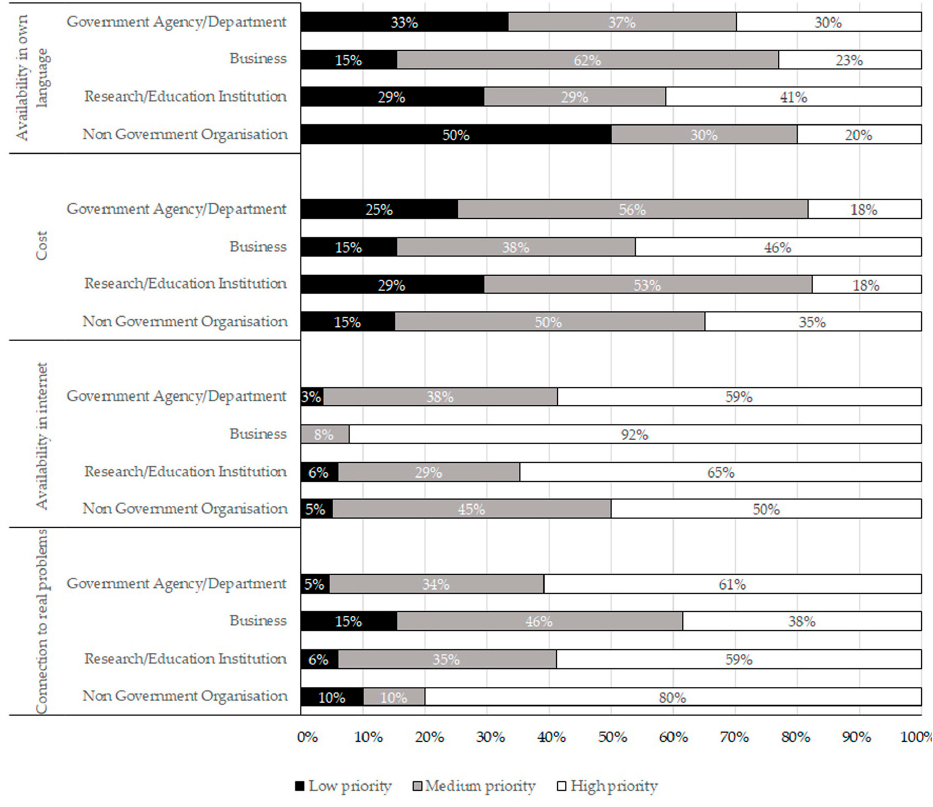
Figure 3. Level of priority given by the respondents from different organisations to aspects of knowledge transfer that should be improved. % of respondents for each level of priority are reported ( n = 137). Looking at the distribution of priorities according to geographical areas (Figure S1), the results show how translation into one’s own language does not have high priority in countries where English is the official language, such as in North America, especially compared to Europe ( p = 0.01) and East Asia ( p = 0.002). Then, Europeans and respondents from Oceania give higher priority to accessibility of resources with respect to respondents from North America ( p = 0.0004 and p = 0.001, respectively) and also for their availability on the internet ( p = 0.002 and p = 0.0027, respectively, with respect to North Americans).